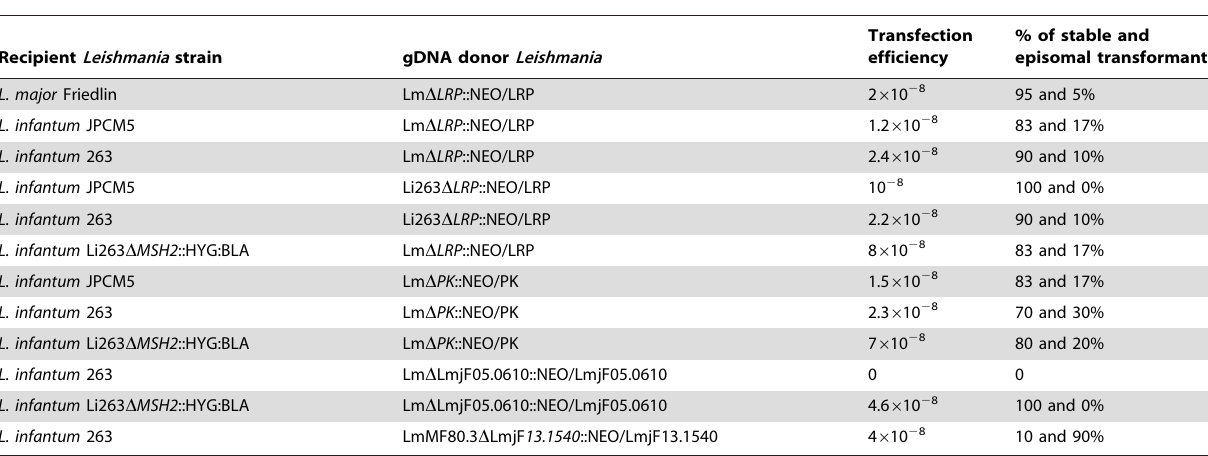
Table 1. Summary of generation of Leishmania hybrids using different